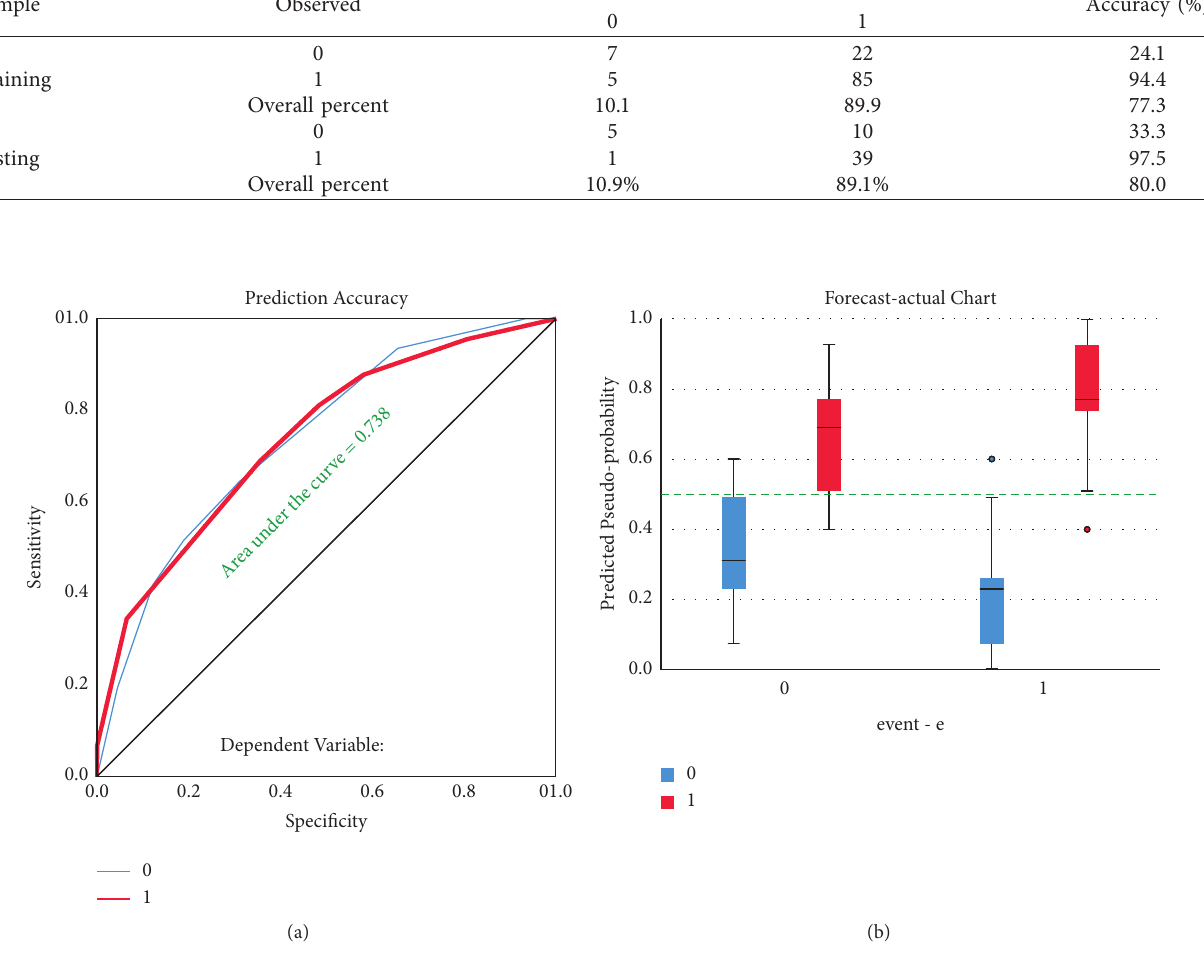
Figure 8: ROC curves and forecast-actual chart for neural network